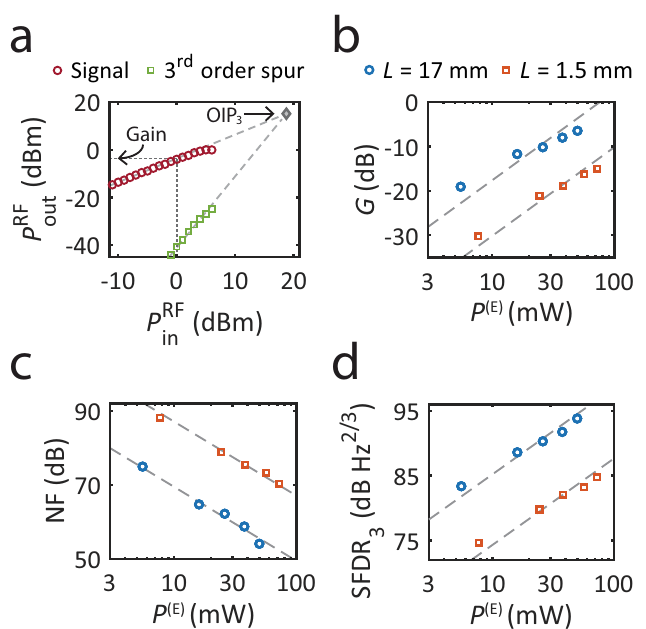
Fig. 4 Microwave-photonic link performance. a Microwave-photonic link measurements; RF output power as a function of RF input power, showing the signal the third-order spur. Extrapolated linear trends and the third- order intercept point are shown for reference. b RF link gain as a function of optical power in the ‘ emit ’ waveguide. The measurements were performed using two different PPER devices, with active lengths of L = 17 mm (blue) and L = 1.5 mm (red). c Corresponding noise fi gure and d third-order spur- free dynamic range. The intermodulation SFDR 3 is 3.2 dB Hz 2/3 lower than the results shown here, which were measured using the third harmonic.